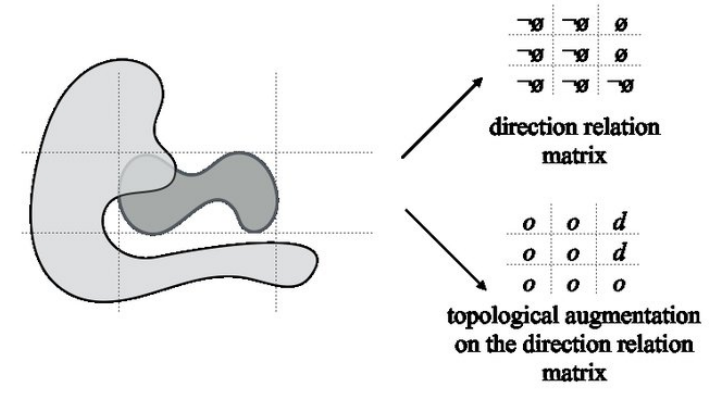
Figure 5: Topological augmentation applied to a pair of objects. The corresponding direc- tion relation matrix symbol is also shown [8].